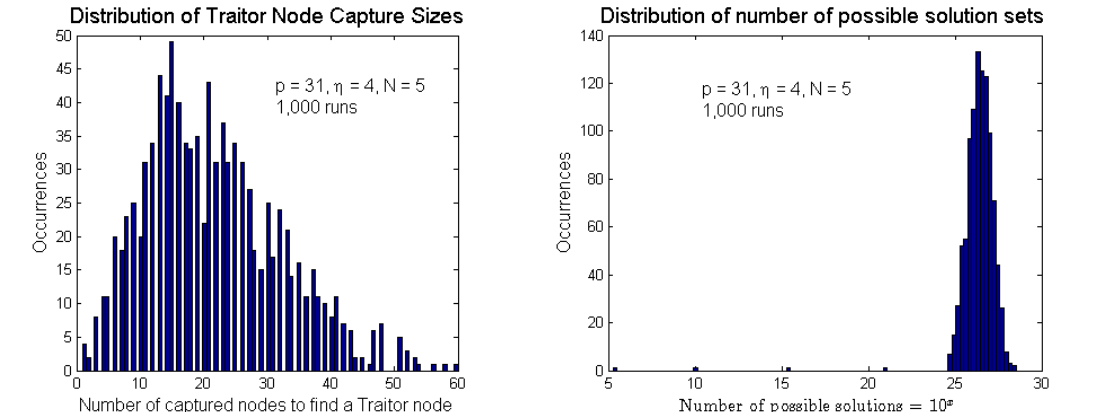
Figure 8. Result of pairing attacks on the scheme using m = 24 , p = 31 , η = 4 , N = 5 .